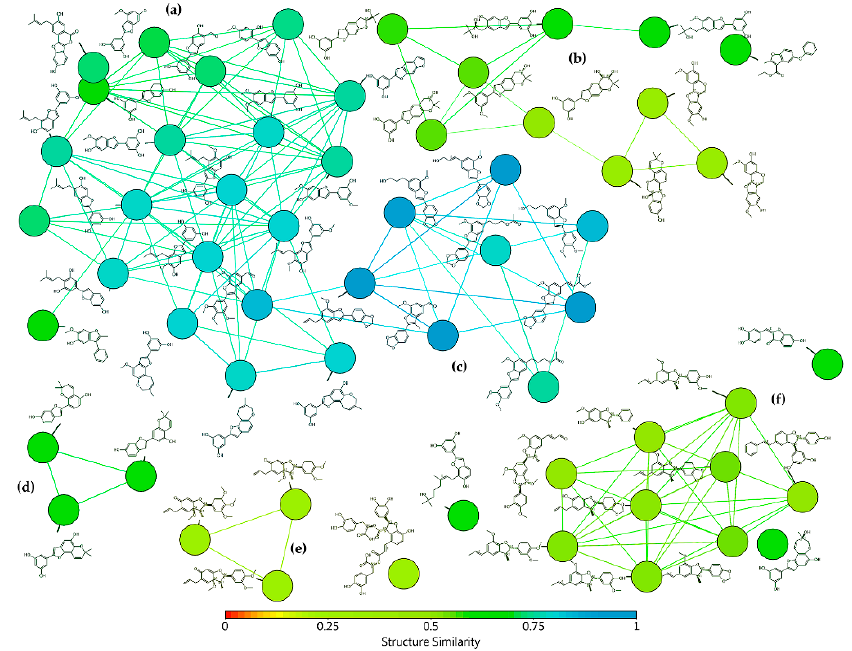
Figure 1. Similarity chart of 2-arylbenzofurans 1–58 after structure similarity analysis using the substructure fragment dictionary-based binary fingerprint descriptor (FragFp) ([17]. Colors according to the heatmap based on the structure similarity index between 0 (red) and 1 (light blue). Clusters according to: ( a ) moracin-type, ( b ) 2 H -pyran- and benzofuro[6.5- b ]furan-containing, ( c ) propyl(en)-susbtituted, ( d ) dihydropyran-containing, ( e ) furocyclohexadienone-type, and ( f )